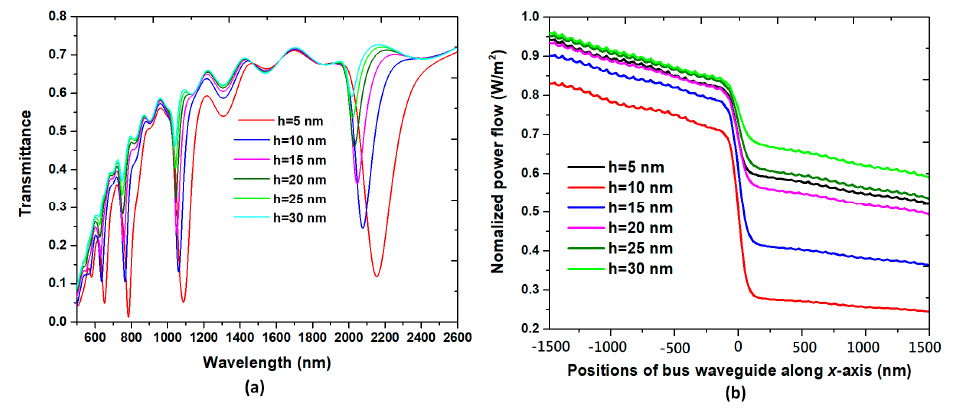
Figure 7. ( a ) Transmittance spectrum of the proposed plasmonic band-stop filter versus different coupling length, h. ( b ) Normalized power flow versus positions of the straight waveguide along the x -axis (at y=0) in the range of −1500 to 1500 nm at different coupling length, h.